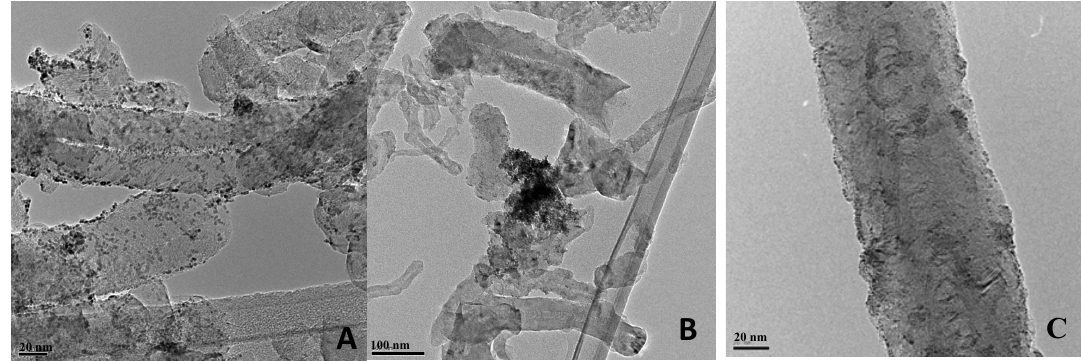
Figure 9. TEM images of PtRuMo/NF ( A ) and PtRuMo/NF.F ( B and C ).